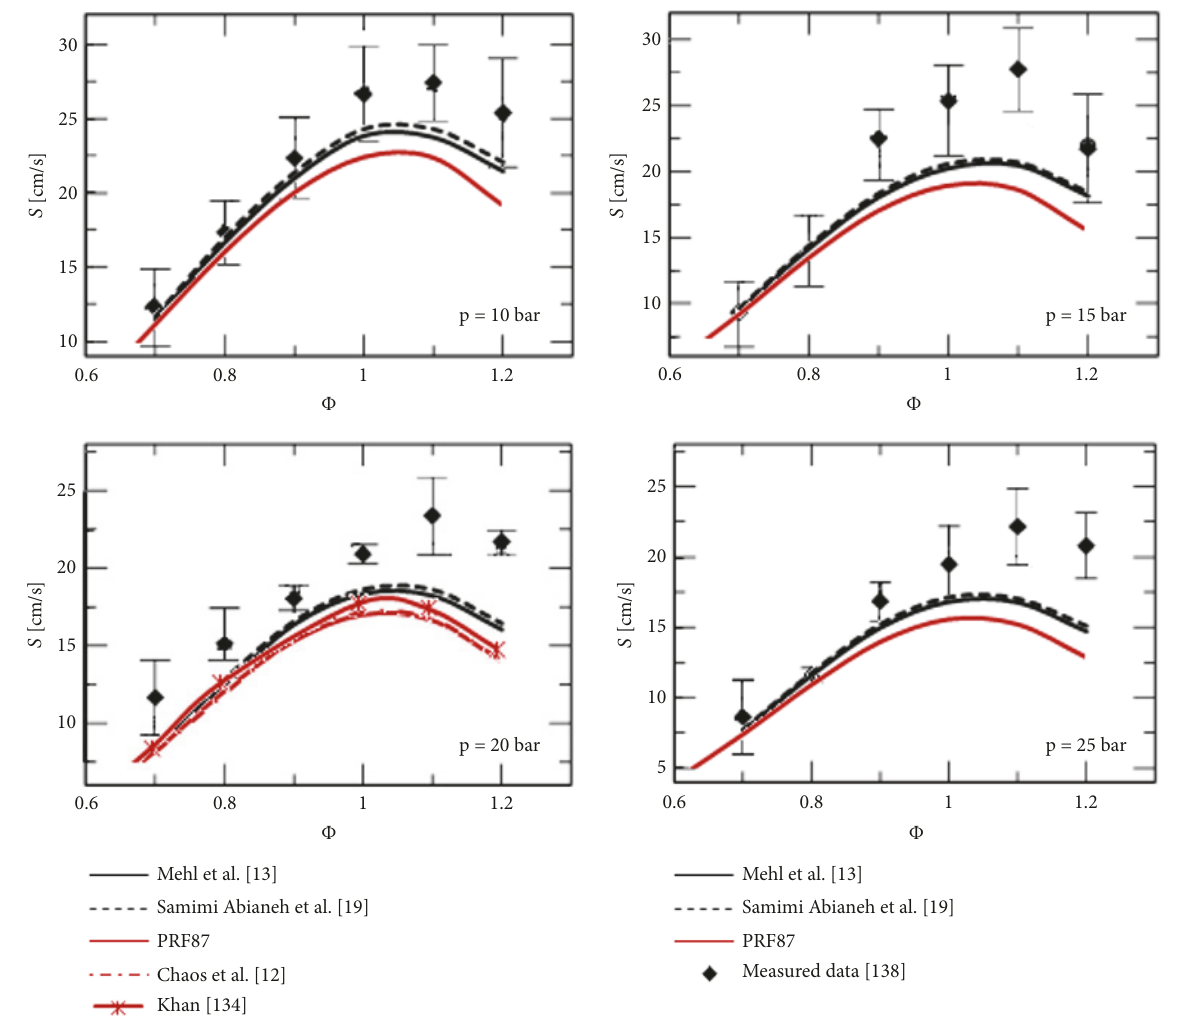
Figure 19: Comparison of measured gasoline laminar flame speeds and several modeled gasoline surrogates. Unburned gas temperature is 373 K and the oxygen mole fraction in air is 0.205 for both the experiments and simulations. Measured data is from Jerzembeck et al.